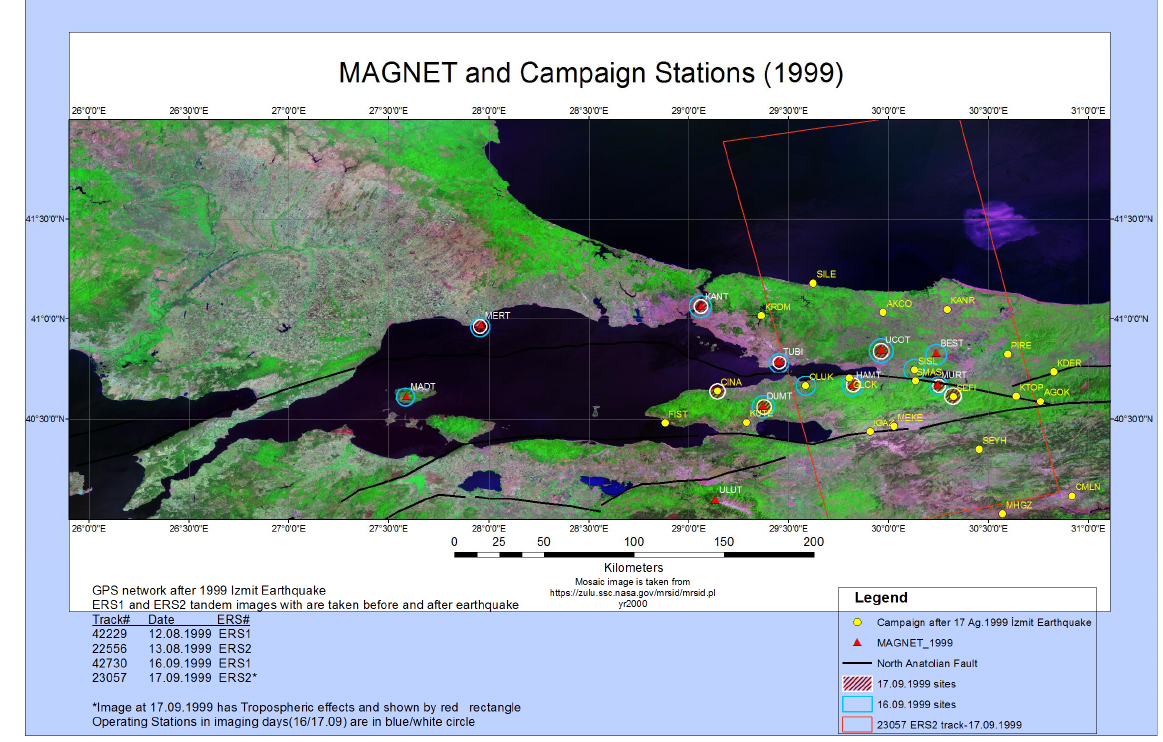
Figure 1. MAGNET and campaign sites after 1999 İzmit Earthquake red rectangle shows the ERS image boundary accurate delay model of troposphere with 12